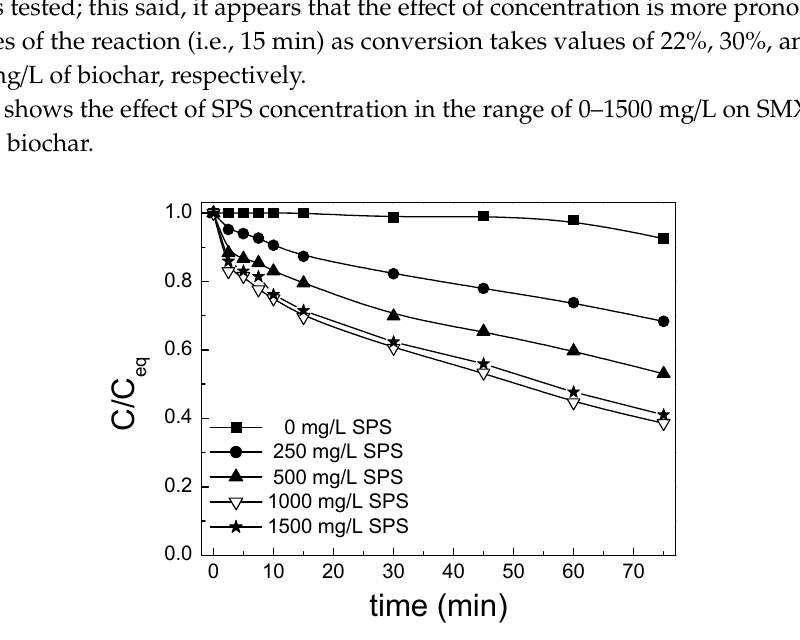
Figure 10. E ff ect of SPS concentration on 500 µ g / L SMX degradation with 200 mg / L biochar in UPW and inherent Figure 10. Effect of SPS concentration on 500 μ g/L SMX degradation with 200 mg/L biochar in UPW and inherent pH.